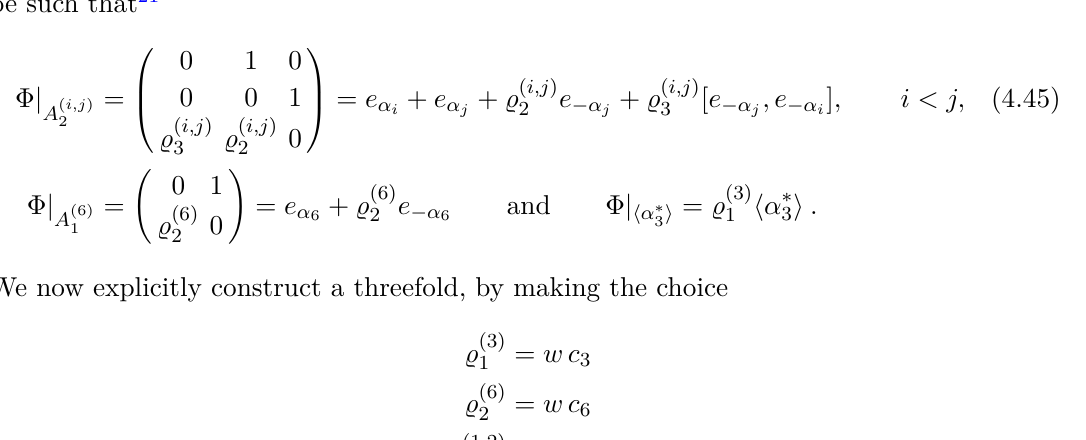
factor of (4.44), plus the coefficient along the Cartan element h α ∗ be such that